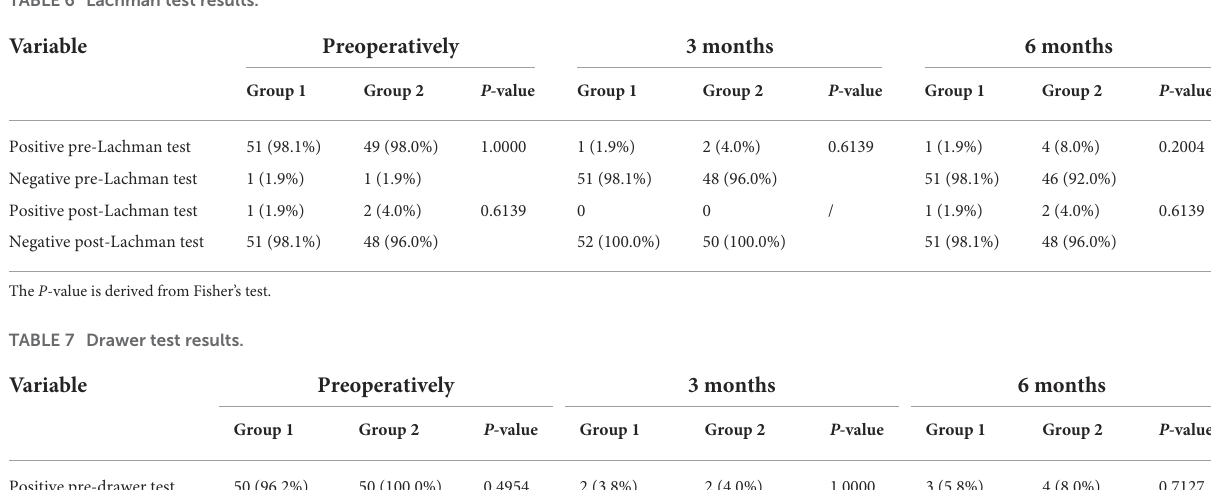
TABLE 6 Lachman test results.